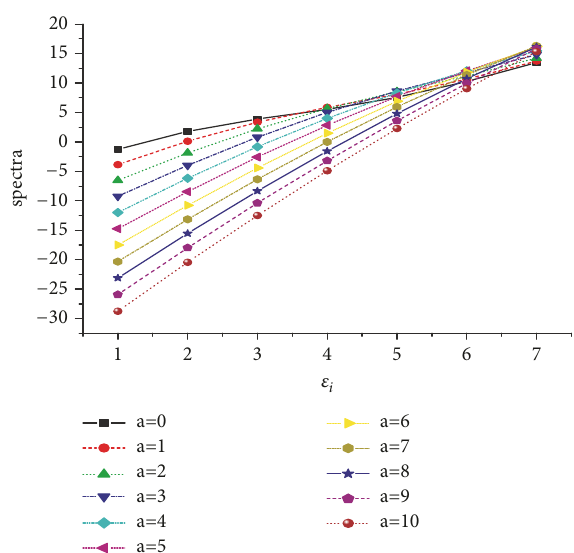
Figure 3: The variation of the energy spectra 𝜖 𝑖 and 𝜉 = 3 .